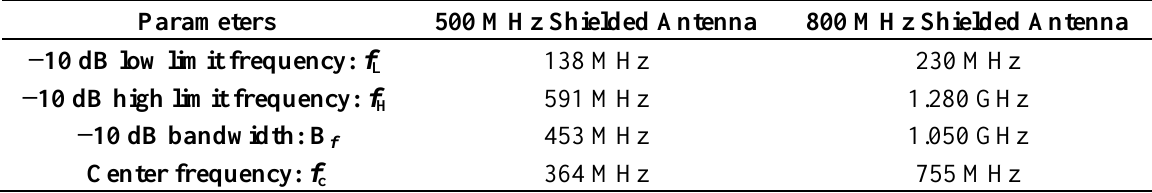
Table 1. Principle parameters of two types of antennas.